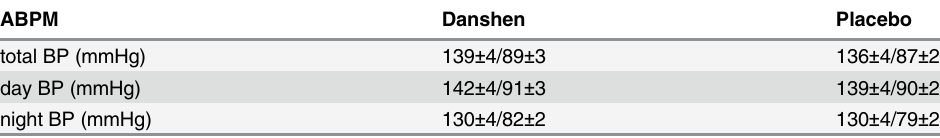
parable results were obtained when data were expressed as absolute and relative changes in FBF from baseline. Table 4. Measurement of Systolic/Diastolic blood pressure before and after treatment with Danshen or placebo. Results are provided as mean ± SEM. BP: blood pressure. ABPM: 24-h Ambulatory Blood Pres- sure